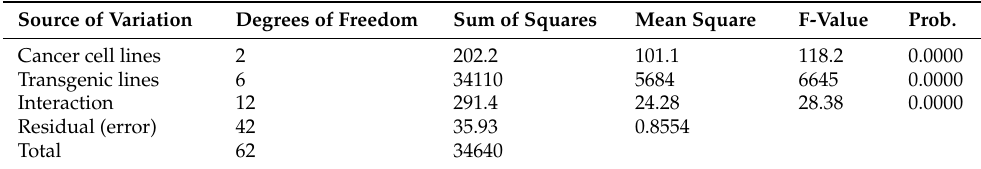
Figure 9. MTT assay for determination of cytotoxic activity of plant extracts (40 mg/mL) against HeLA, MCF7, and HePG2 cancer cell lines. Table 5. Two-way ANOVA for MTT assay